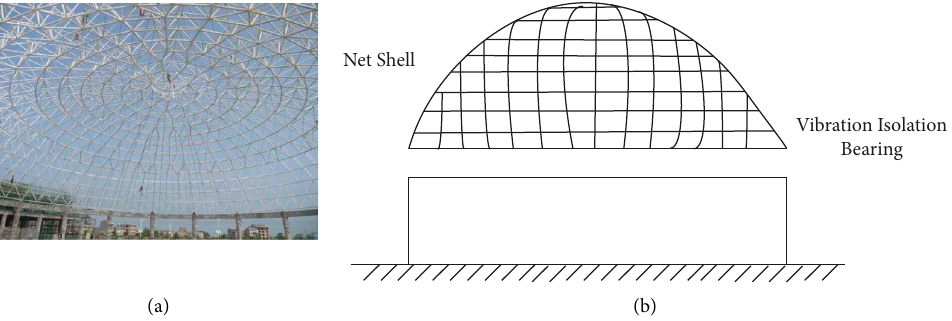
Figure 7: Double-layer spherical mesh shell structure model and arrangement